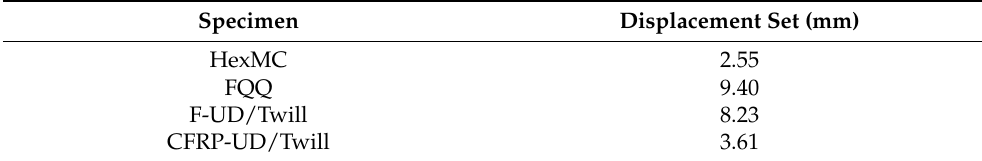
Table 5. Deflection